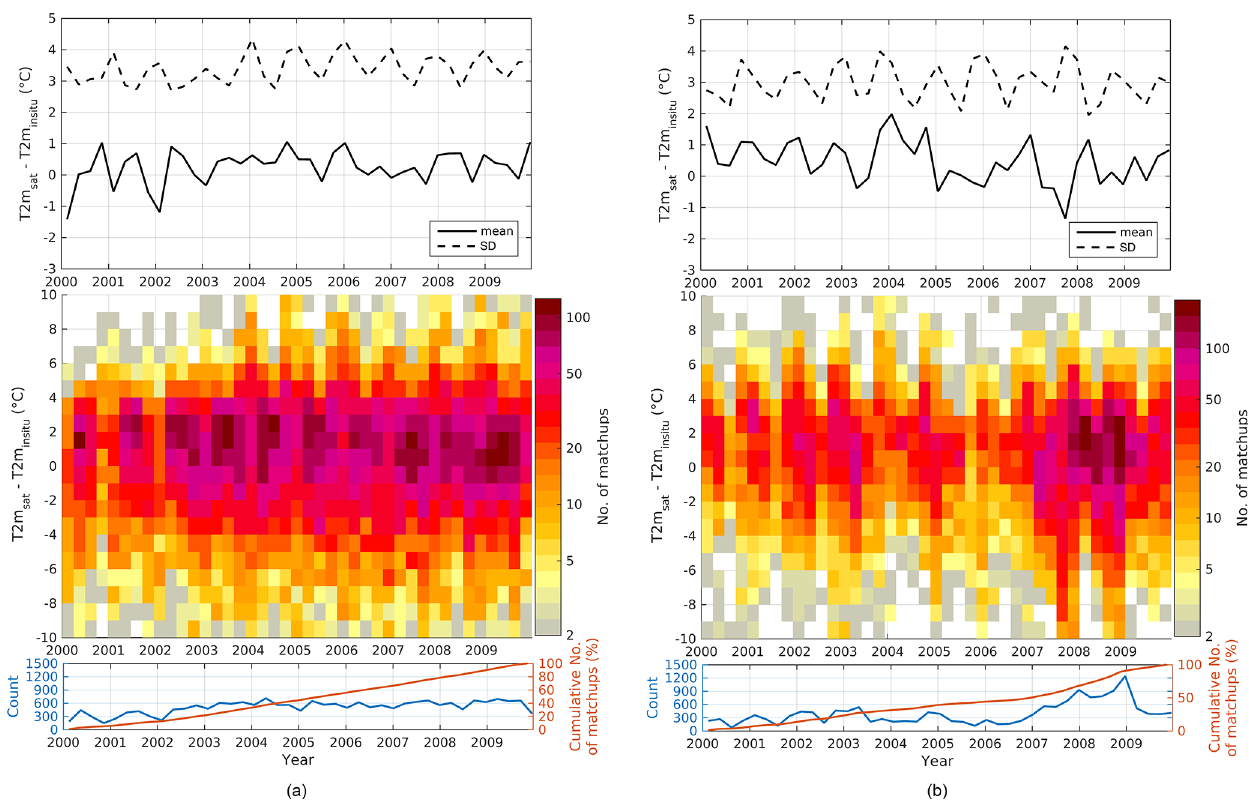
Figure 8. Estimated T2m minus observed T2m (bin size of 1 ◦ C) for the full time period (bin size of 90d) for (a) land ice and (b) sea ice. The dashed lines are standard deviations while the solid lines are bias in the upper figures. The surface plots in the middle figures show the number of matchups in each bin, while the bottom plots show the number of matchups (blue) and the cumulative percentage of matchups (red) in each time bin. Table 7. Statistics on the relation between ERA-I/ERA5 and in situ measured temperatures for independent test data. N : number of